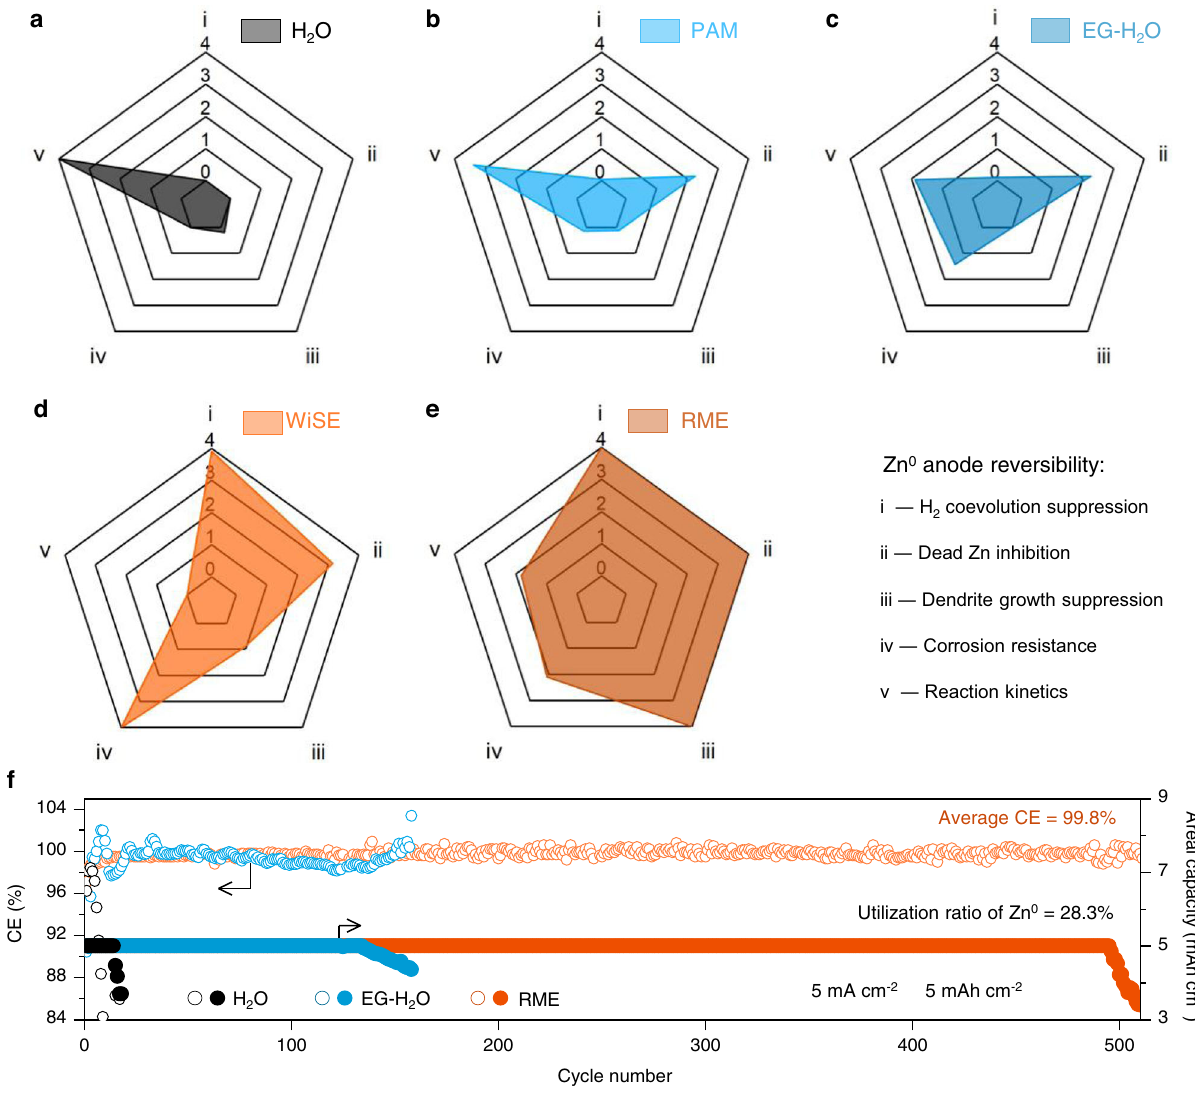
Fig. 4 | Comprehensive evaluation of Zn 0 anode reversibility in the H 2 O, the PAM, the EG-H 2 O, the WiSE, and the RME. Radar plot assessing Zn 0 anode reversibility in the H 2 O ( a ), the PAM ( b ), the EG-H 2 O ( c ), the WiSE ( d ) and the RME ( e ). Five normalized grades ranging from 0 to 4 are given according to the mea- sured performance in each electrolyte. The grade of 0 represents poor H 2 coevo- lution suppression, poor dead Zn inhibition, poor dendrite suppression and low corrosionresistanceandlowreactionkinetics;while4standsfortheopposite,ideal